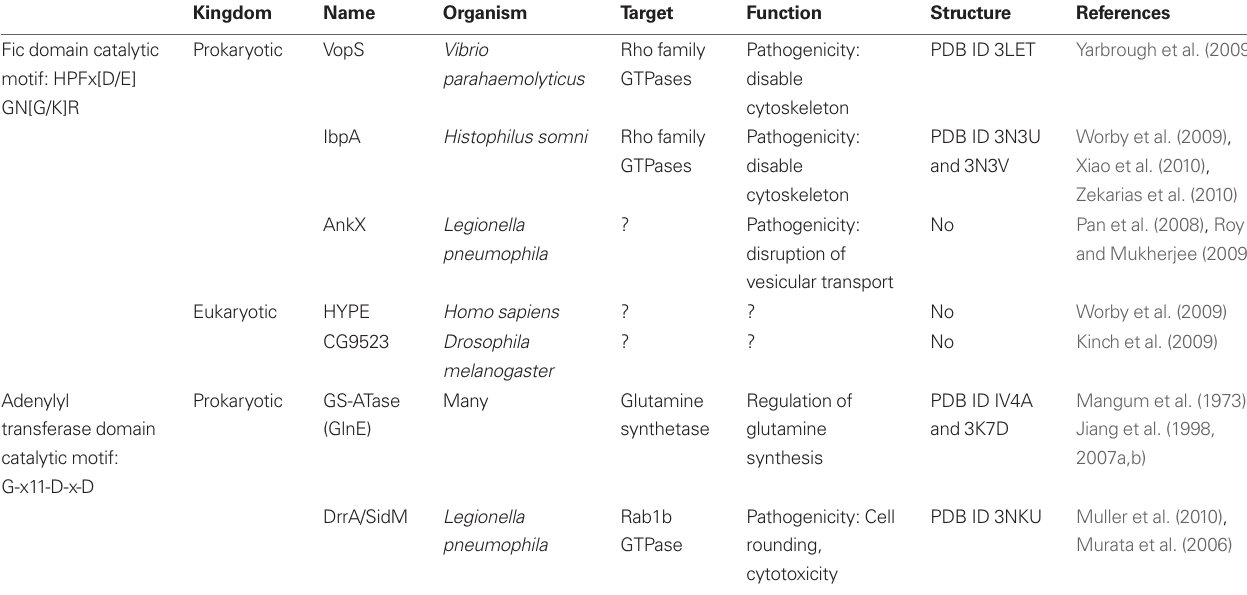
Table 1 | Fic and adenylyl transferase